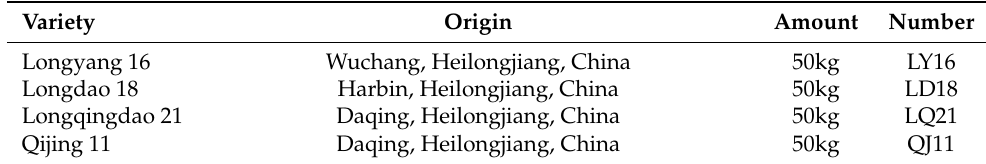
Table 1. Rice sampling information for traceability experiments under differential privacy guarantee.